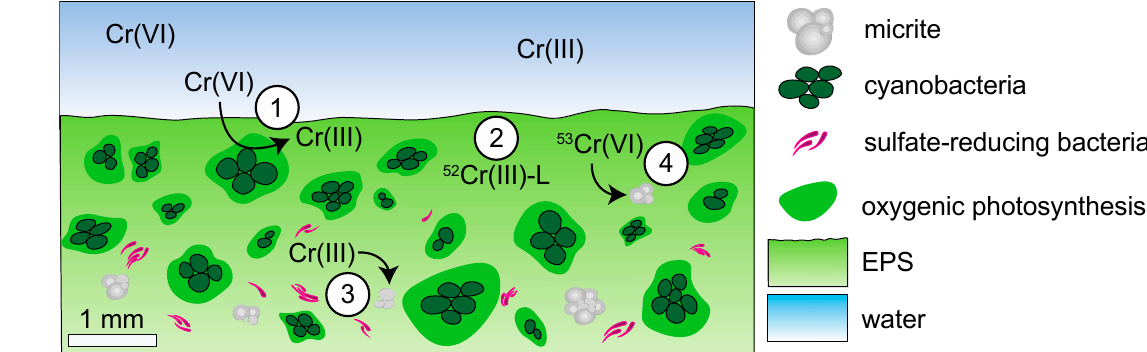
Figure 7. Illustration of a potential Cr incorporation pathway: (1) Cr reduction by microbes, (2) complexation of Cr(III) with ligands (L), which (3) limits its availability compared with open marine conditions. (4) Isotopically heavy Cr(VI) is incorporated into micritic carbonate. The general idea for carbonate precipitation within microbial mats is adapted from [80–82].